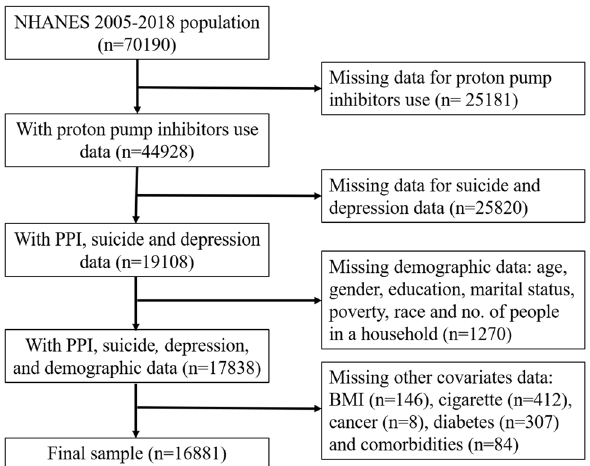
Figure 1. Flow chart of the study